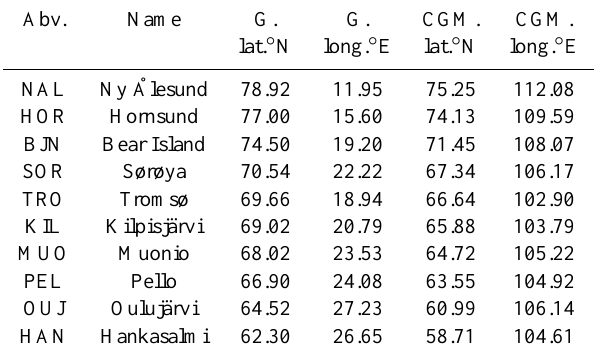
Table 1. Coordinates of stations.